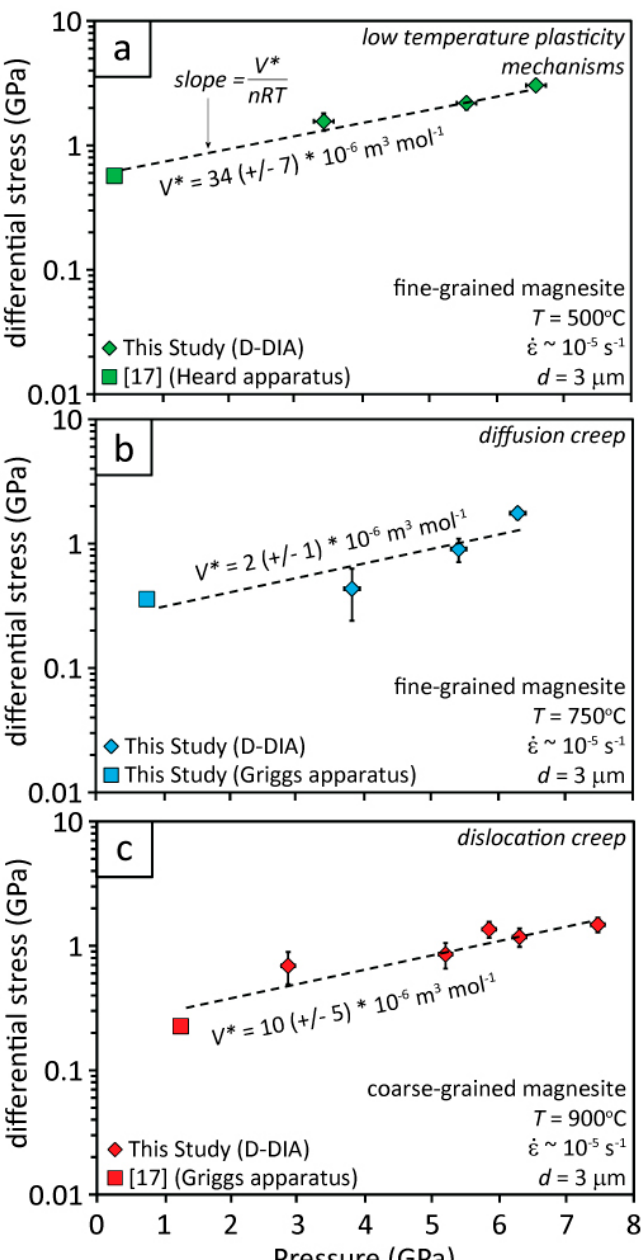
Figure 10. The strengths of magnesite aggregates deformed at T = 500 ( a ), 750 ( b ) and 900 °C ( c ) all increase as a function of increasing pressure. Activation volumes ( V* ) for magnesite deformed by LTP mechanisms, diffusion creep and dislocation creep are 34, 2 and 10 × 10 − 6 m 3 mol − 1 .